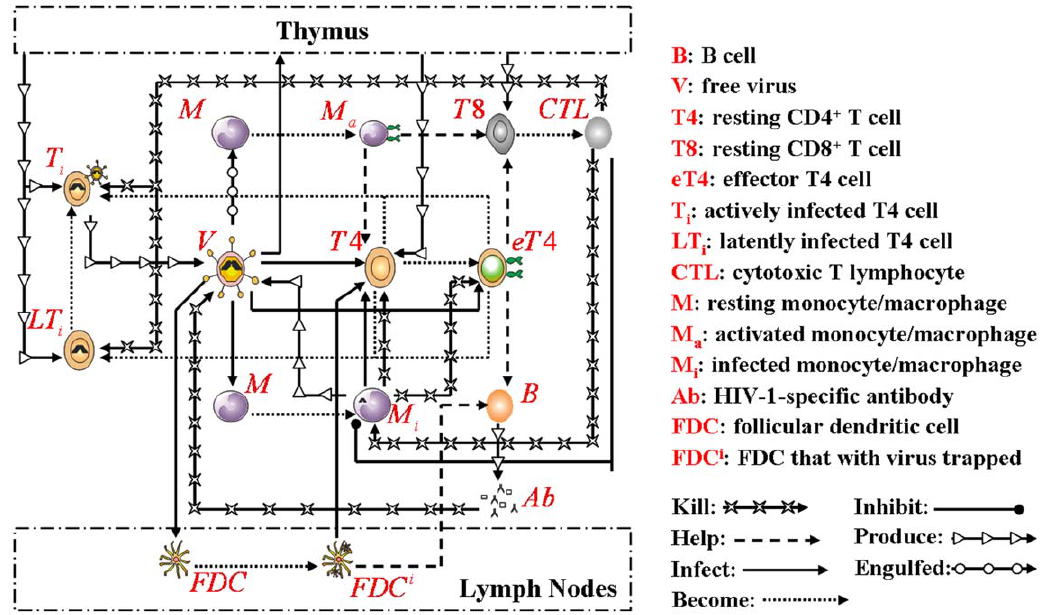
Figure 10. Immune response during HIV-1 infection. Viral particles could either be engulfed by monocytes/macrophages or infect those cells and T4 cells, causing a dramatic decline in T4 cells counts. After the immune recognition of HIV-1 antigens by activated monocytes/macrophages and the stimulation of HIV-1-specific T4 cell proliferation and differentiation, both the humoral and cell-mediated immunity responses took place. These are characterized by the proliferation of T8 cells and production of HIV-1-specific antibodies from B cells. T8 cells can kill infected T4 cells and monocytes/macrophages, and HIV-1-specific antibodies can inactivate free viruses and remove them. Free viral particles could either be produced from infected monocytes/macrophages or infected T4 cells. Viruses could also seed the thymus and LNs, causing the infection of newly produced T4 cells and forming a large virus pool in the LNs. In LNs, viruses are mainly trapped on the dendrites of FDCs.